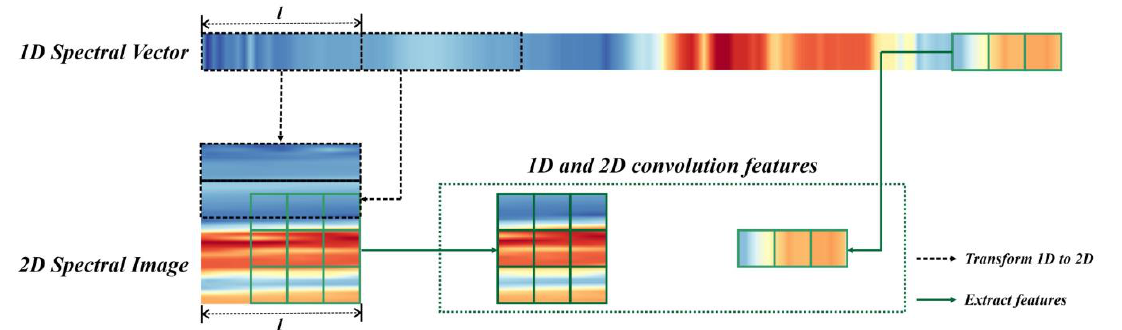
Figure 2. The process of transforming 1D spectral vector into 2D spectral image and the comparison of features obtained using 1D and 2D convolution